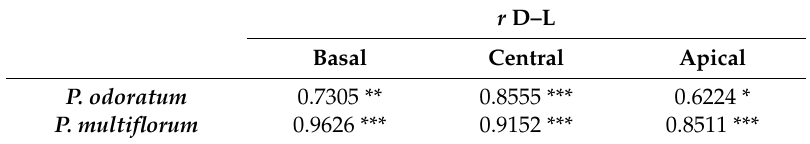
Table 3. Values of Pearson’s correlation coefficients ( r ) between diameter (D) and length (L) of the shoot for the two species P. odoratum and P. multiflorum based on three regions of the shoot (basal, central and apical).